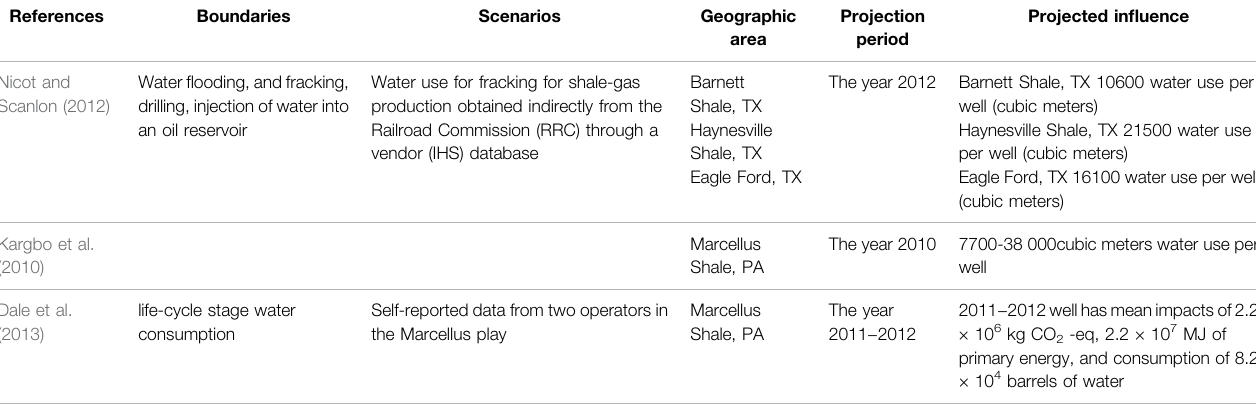
TABLE 1 | Most relevant studies on water usage and wastewater on shale gas